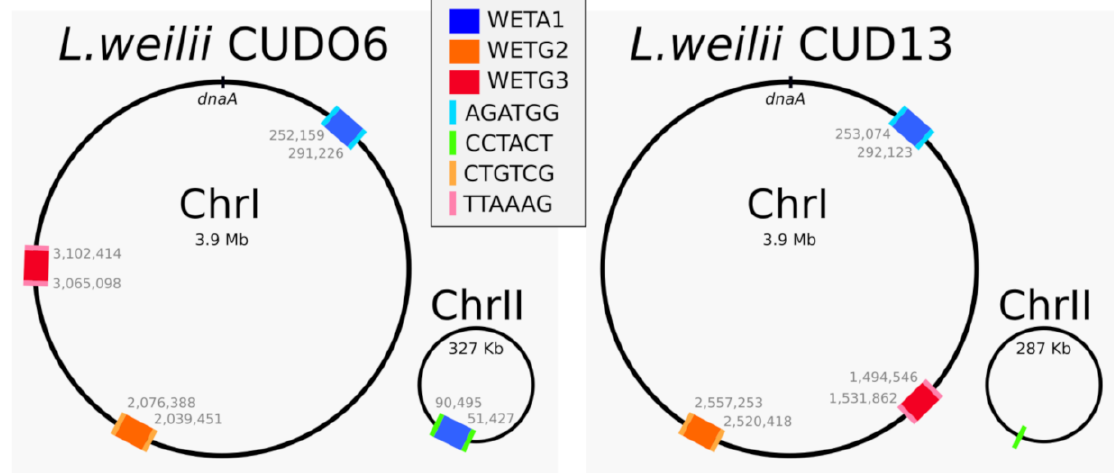
Figure 1. Location of the seven predicted prophages in L. weilii CUDO6 and CUD13. The different copies of the three distinct prophages WETA1, WETG2, and WETG3 are colored, as well as the sequences of the flanking 6 bp repeats. See text for